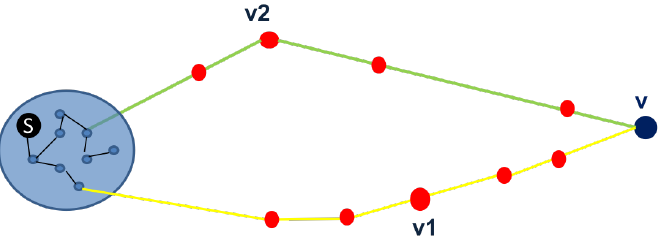
Figure 9. Illustration of two possible paths for connecting the blue vertex v to the component of the sink vertex s , one through relay vertex v 1 , and another through relay vertex v 2 .